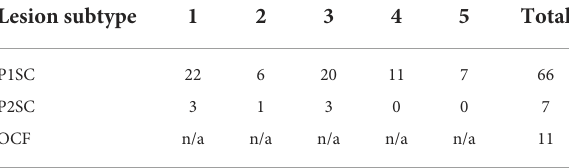
TABLE 2 PIPJ JOC lesions by type and subtype.